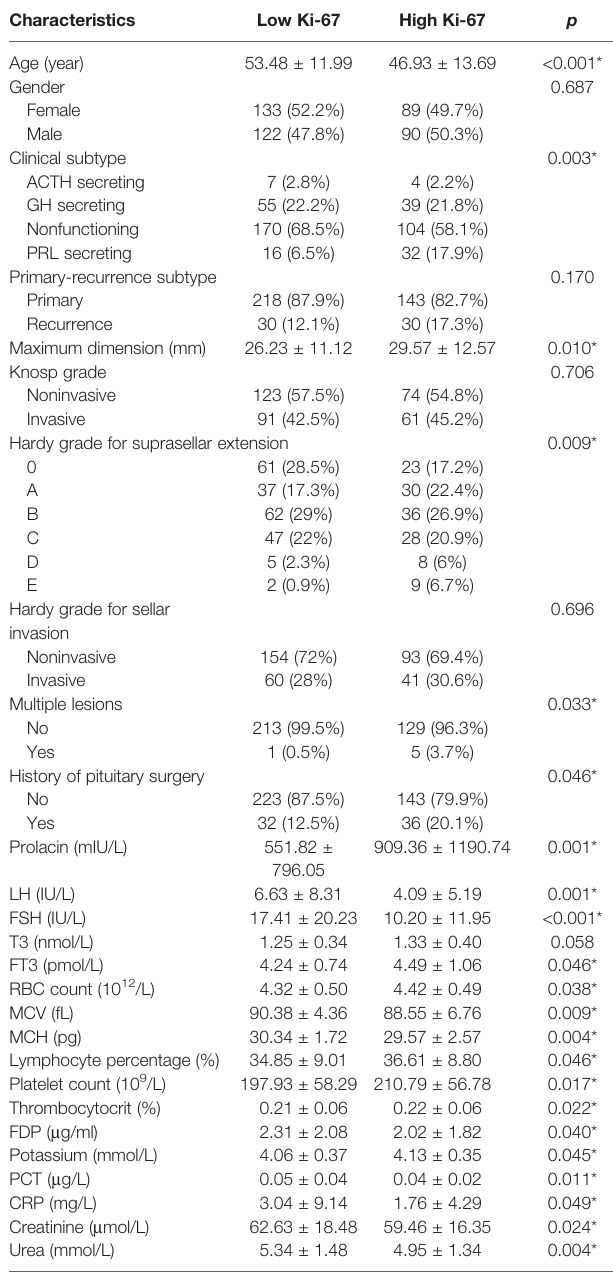
TABLE 1 | Important characteristics of patients with PAs in the low and high Ki- 67 cohorts.